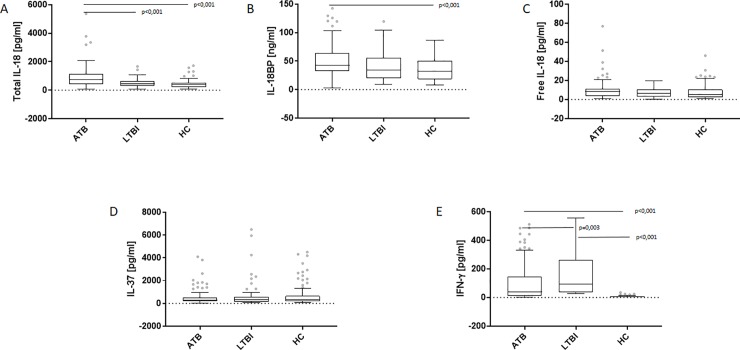
Total IL-18, IL-18BP, free IL-18, IL-37 and IFN-γ levels in M.tb antigens-stimulated QuantiFERON (QFT) supernatants.Boxplots with median (horizontal line within the box), interquartile range (box limits), and extremes (whiskers) of levels of total IL-18 (A), IL-18BP (B), free IL-18 (C), IL-37 (D) and IFN-γ (E) in M.tb antigens-stimulated QFT supernatants in the groups of patients with active tuberculosis (ATB) and latent M.tb infection (LTBI) and healthy controls (HC).